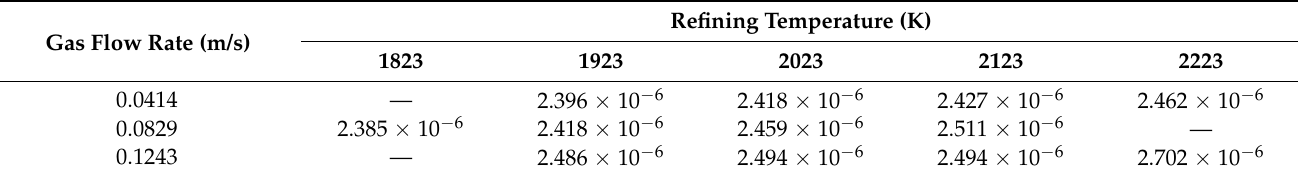
Table 3. Total mass transfer coefficients for dephosphorization under different experimental conditions (m/s). Gas Flow Rate